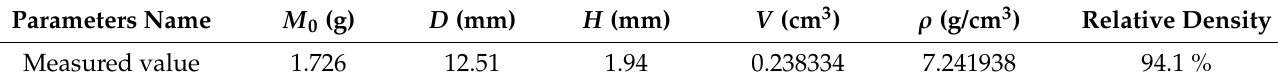
Table 5. The density of the circular Bi 2 Te 3 solid-state